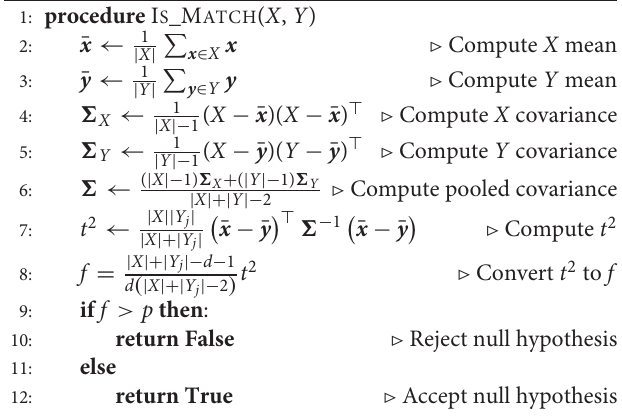
Algorithm 2 : Unpaired multivariate t -test using Hotelling’s t -squared statistic. Here, we use a slight abuse of notation when computing covariance matrices by assuming sets of d - dimensional vectors can also be treated as matrices whose rows correspond to their d -dimensional elements. We assume a p - value is fixed a priori. In our implementation, we replace all standard matrix inversions with the Moore-Penrose pseudo-